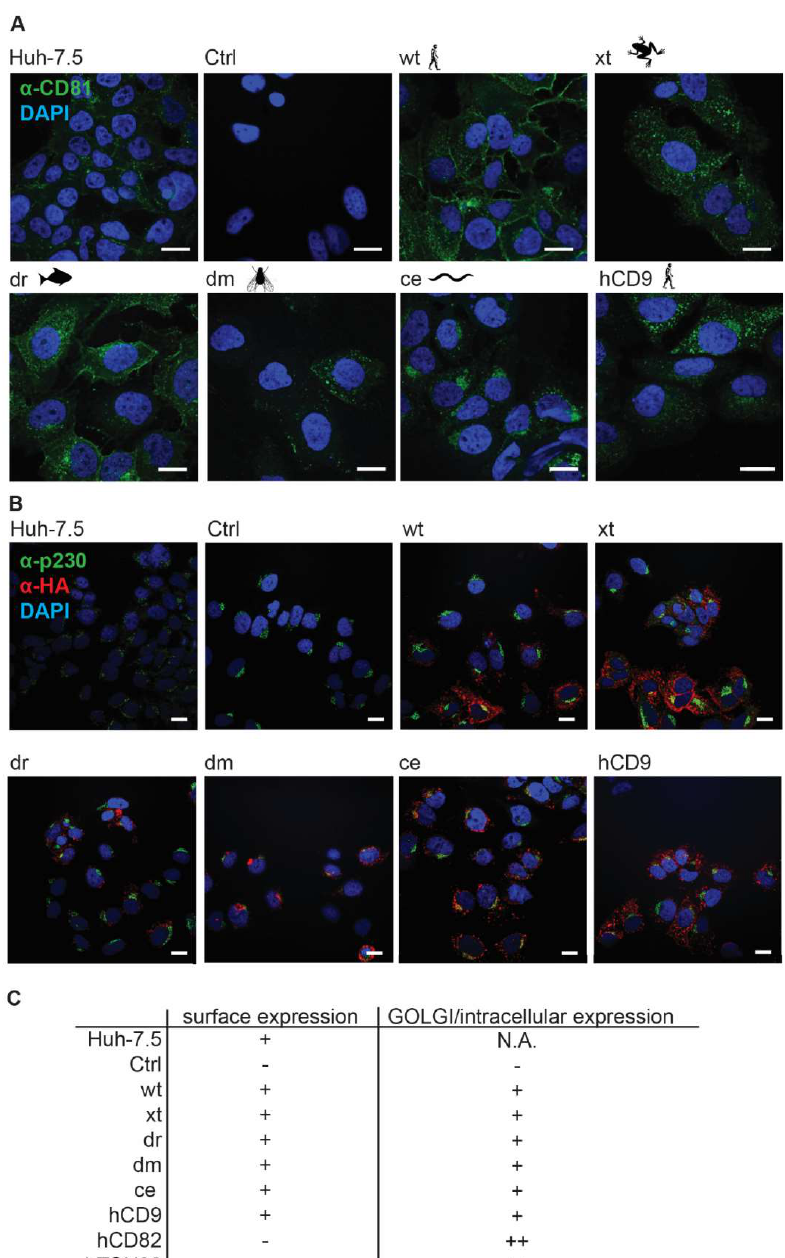
Figure 4. Subcellular distribution analysis of the five surface expressed hCD81 chimeras and full length hCD81 in Lunet N#3 and Huh-7.5 cells. ( A ) Confocal microscopy of hCD81 LEL stained Lunet N#3 cells expressing the indicated tetraspanin chimeras. Cells were permeabilized and stained with anti-hCD81 antibody (clone JS-81, green). Nuclei were stained with DAPI (blue). Huh-7.5 cells served as positive control, scale bars = 20 μm ( B ) Confocal microscopy of Lunet N#3 and Huh-7.5 cells stained with anti-HA antibody (red), anti-p230 antibody (green) as Golgi marker and DAPI (blue). Representative images; scale bars = 20 μm. ( C ) Semi-quantitative analysis of hCD81 chimera subcellular localization. +, expression observed; −, expression not observed; N.A., data not available.